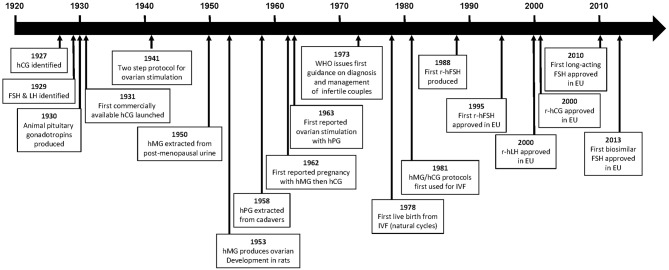
Time line of major events in the development of gonadotropins. CHO, Chinese hamster ovary; FSH, follicle-stimulating hormone; hCG, human chorionic gonadotropin; hMG, human menopausal gonadotropin; LH, luteinizing hormone; r-hCG, recombinant human chorionic gonadotropin; r-hFSH, recombinant human follicle-stimulating hormone; r-hLH, recombinant human luteinizing gonadotropin.